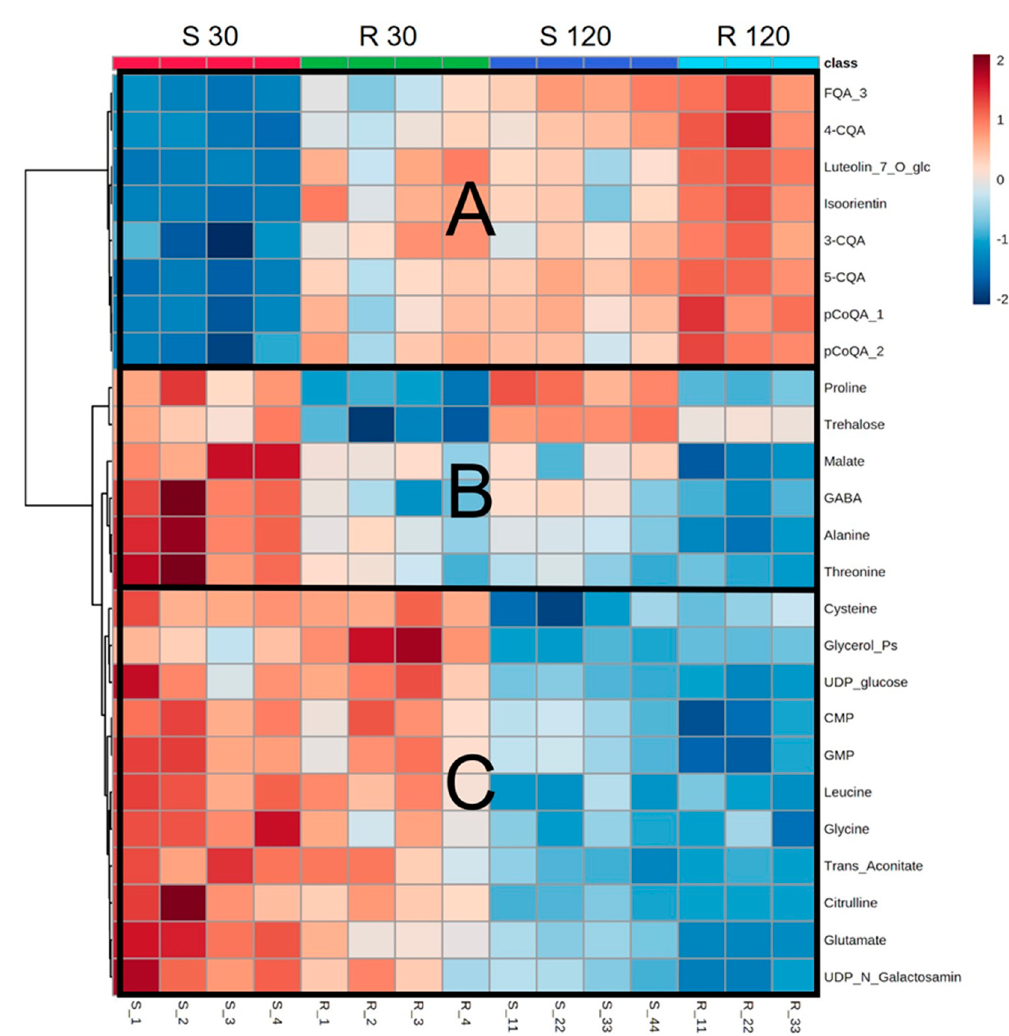
Figure 4. Heatmap showing the top 25 ANOVA compounds of leaf extracts quantified by targeted metabolomics from the mock-inoculated plants of the S and R varieties collected at 30 and 120 DAI. Colors represent metabolite relative intensity, where red represents high values and blue represents low values, and fold changes are represented by the color scale. Highlighted sections represent groups of compounds that are low in S30 and high in S120 ( A ), high in S 30 ( B ), and higher at 30 vs. 120 DAI ( C ). Abbreviations: FQA_3, feruloylquinic acid isomer 3; 4-CQA, 4-caffeoylquinic acid; Luteolin_7_O_glc, luteolin-7-O-glucoside; 3-CQA, 3-caffeoylquinic acid; 5-CQA, 5-caffeoylquinic acid; pCoQA_1, p-coumaroylquinic acid isomer 1; pCoQA_2, p-coumaroylquinic acid isomer 1; GABA, gamma aminobutyric acid; Glycerol_Ps, glycerol phosphates; UDP_glucose, uracil diphosphate glucose; CMP, cytidine monophosphate; GMP, guanosine monophosphate; UDP_N_Galactosamin, uridine diphosphate-N-galactosamine.